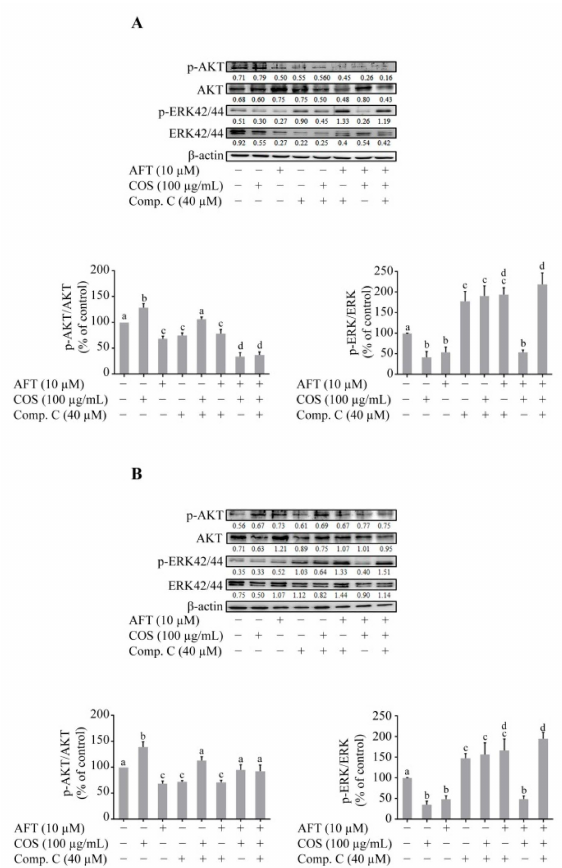
Figure 5. The effect of COS on AKT and ERK phosphorylation. ( A ) T84 cells were treated with the indicated concentrations of COS, afatinib, or both in the presence or absence of Compound C (40 µ M) for 24 h. ( B ) In combined treatment, after 30 min pre-incubation of Compound C, cells were exposed to COS for 4 h followed by 24-h afatinib treatment. Data were analyzed as the ratio of p-AKT/AKT, p-ERK/ERK and expressed as % of control (vehicle − treated group), means ± SD ( n = 3; p < 0.05 one-way ANOVA). Columns not sharing the same superscript letters differ significantly ( p < 0.05, Tukey’s post hoc